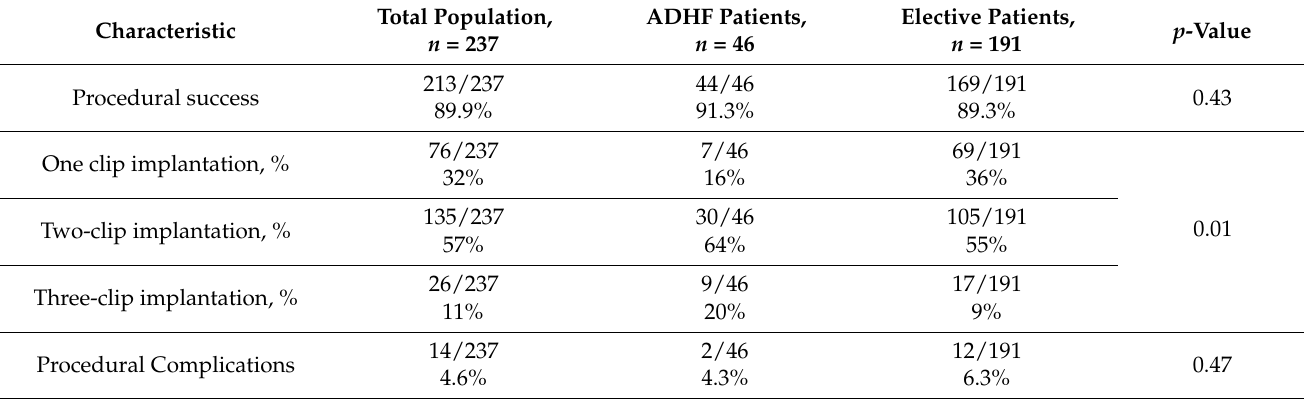
Table 3. Periprocedural characteristics of patient population underwent PMVr.